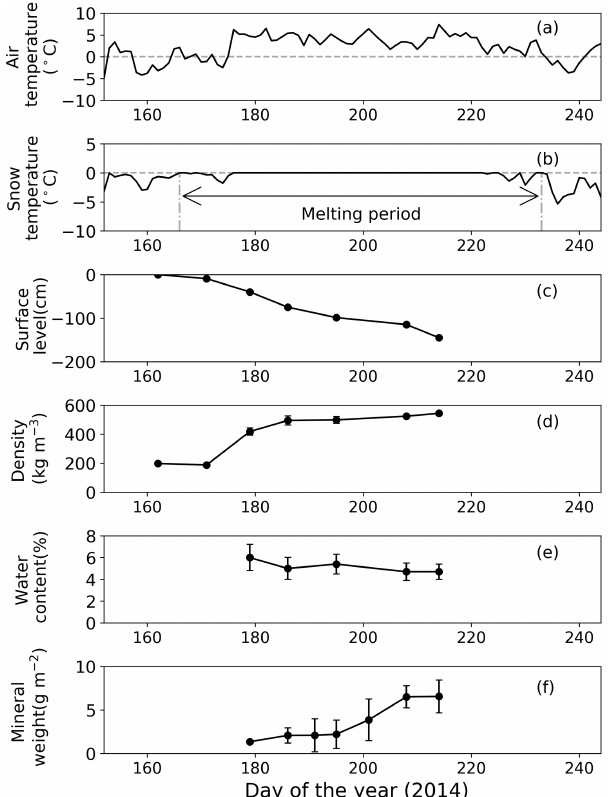
Figure 3. Meteorological and physical conditions of surface snow at Site A from 1 June to 1 September 2014. (a) Mean daily air tem- perature, (b) mean daily snow surface temperature calculated from observed downward and upward long-wave radiant fluxes, (c) rel- ative snow surface level at the site (0cm on day 162), (d) snow density, (e) volumetric liquid-water content of snow, and (f) abun- dance of mineral particles. Melt period in (b) is defined as the period from the first day to the last day on which mean daily snow surface temperature was 0 ◦ C from 1 June to 1 September 2014. Standard deviation shown by error